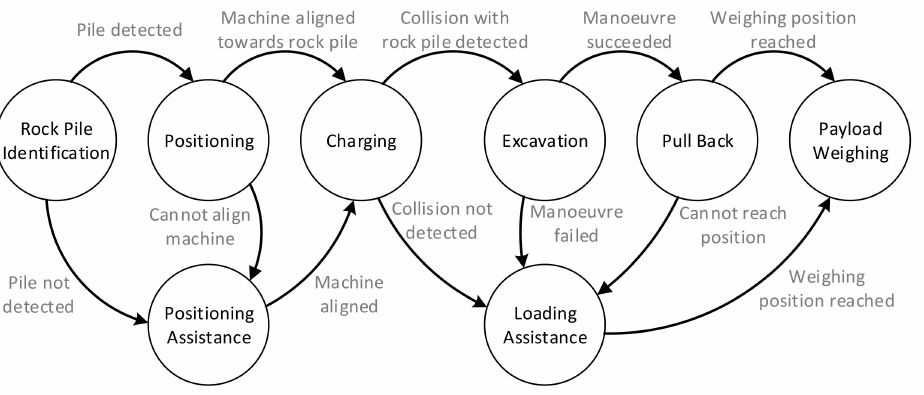
Figure 6. Finite state machine formulation for the autonomous loading with human operators in-the-loop.